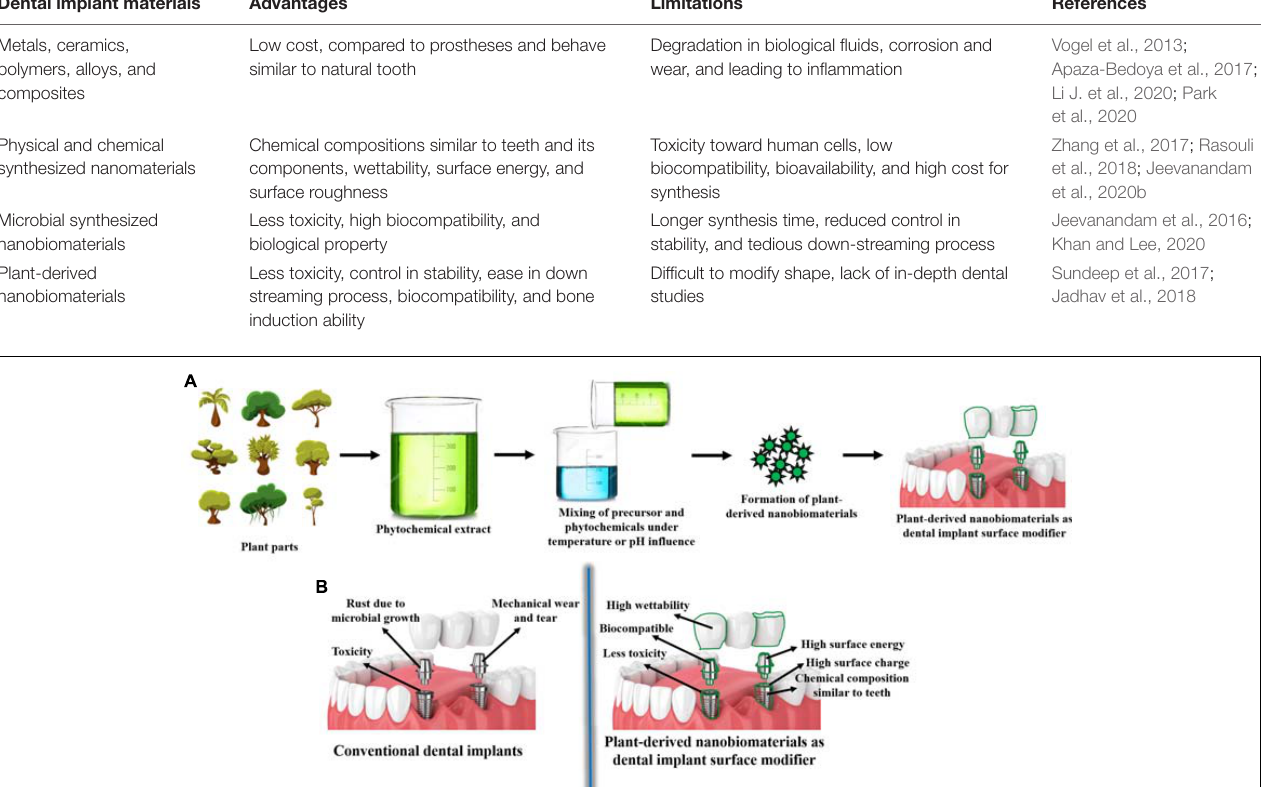
Frontiers in Materials |